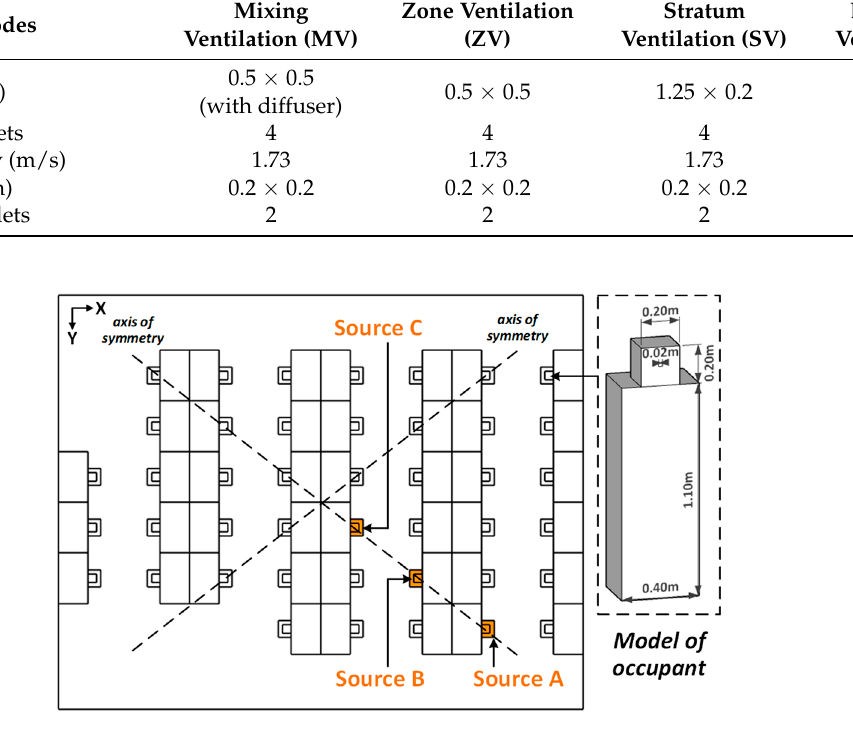
Figure 3. Layout of three infected occupants (source) of A, B and C in the office.